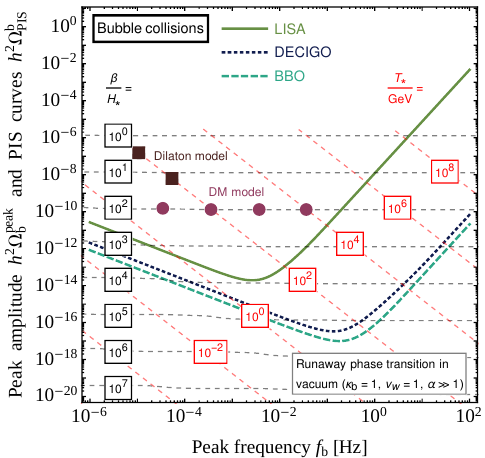
Figure 7 . Contours of constant β/H ∗ and T ∗ in the case of a runaway phase transition in